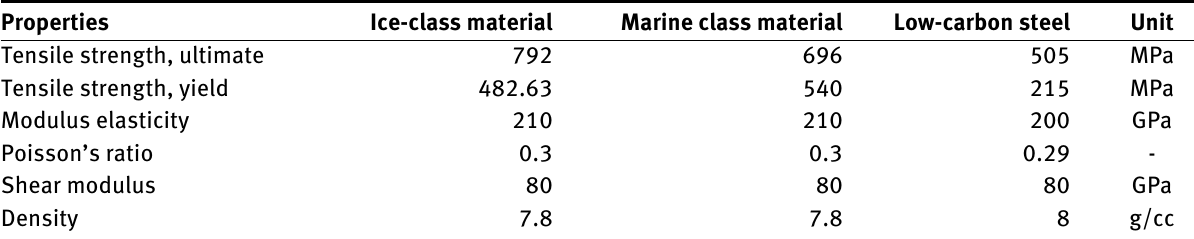
Table 5: Material properties of low-carbon steel AISI 304, AR 235, and AISI 1090 carbon steel